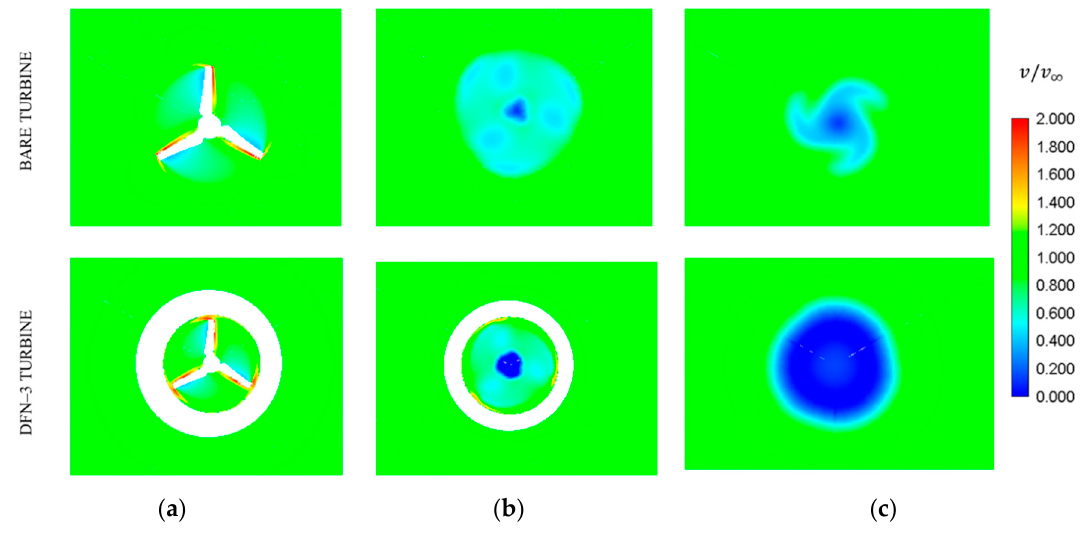
Figure 11. Normalized velocity at axial distance: ( a ) 0D; ( b ) 0.25D; ( c ) 3D downstream of the hub center.